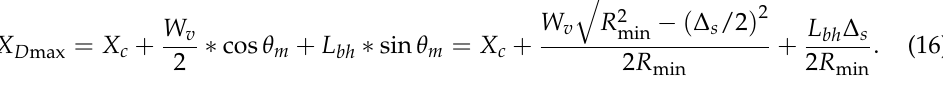
Figure 4. Two cases of S-shaped backward movement.